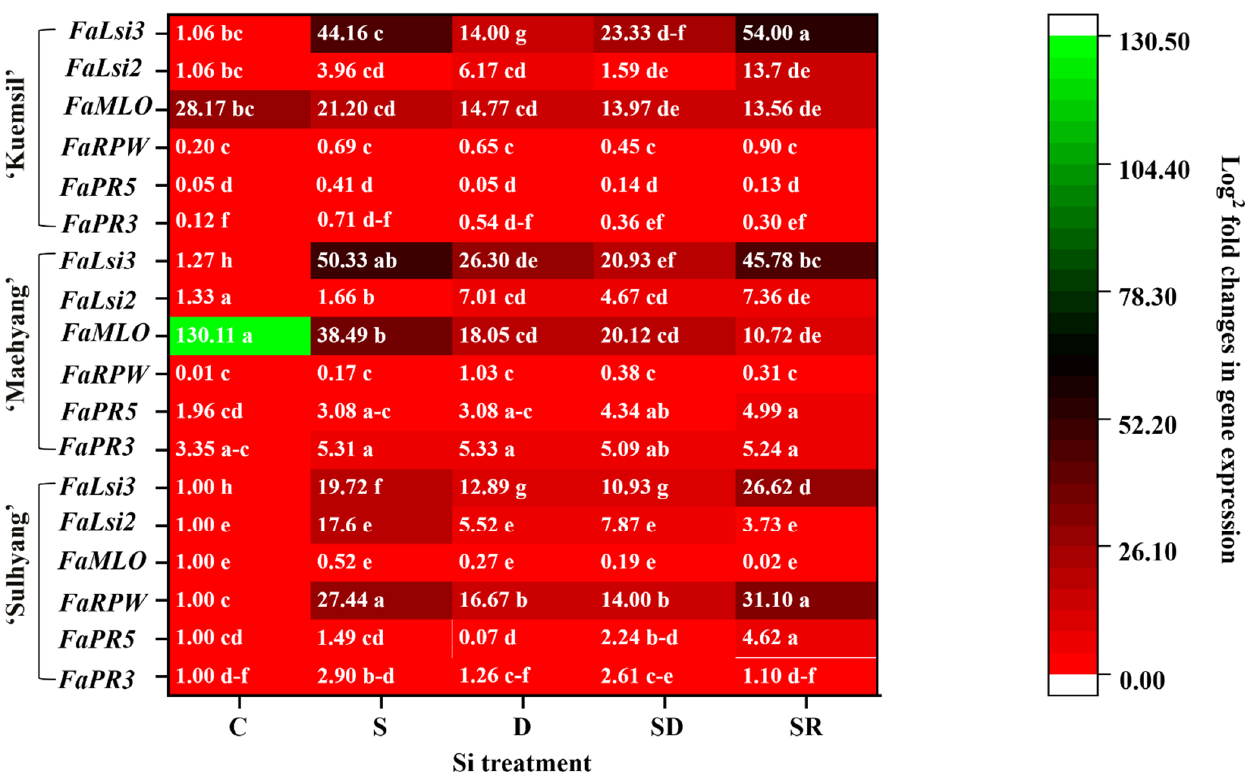
Figure 11. Expression profile heat map of pathogenesis-related 3 ( PR3 ), PR5 , resistance to powdery mildew 8 ( RPW8 ), mildew resistance locus o 10 ( MLO10 ), low silicon rice 2 ( Lsi2 ) and Lsi3 in strawberry “daughter” plants ‘Sulhyang’, ‘Maehyang’, and ‘Kuemsil’. The gene expression is presented with a scale of fold change calculated by 2 −ΔΔCT . Lowercase letters indicate significant differences calculated by the Duncan’s multiple range test at p ≤ 0.05: C, control; S, sprayed “mother” plant; D, drenched “mother” plant; SD, dressed “mother” plant; and SR, sprayed “daughter” plant.